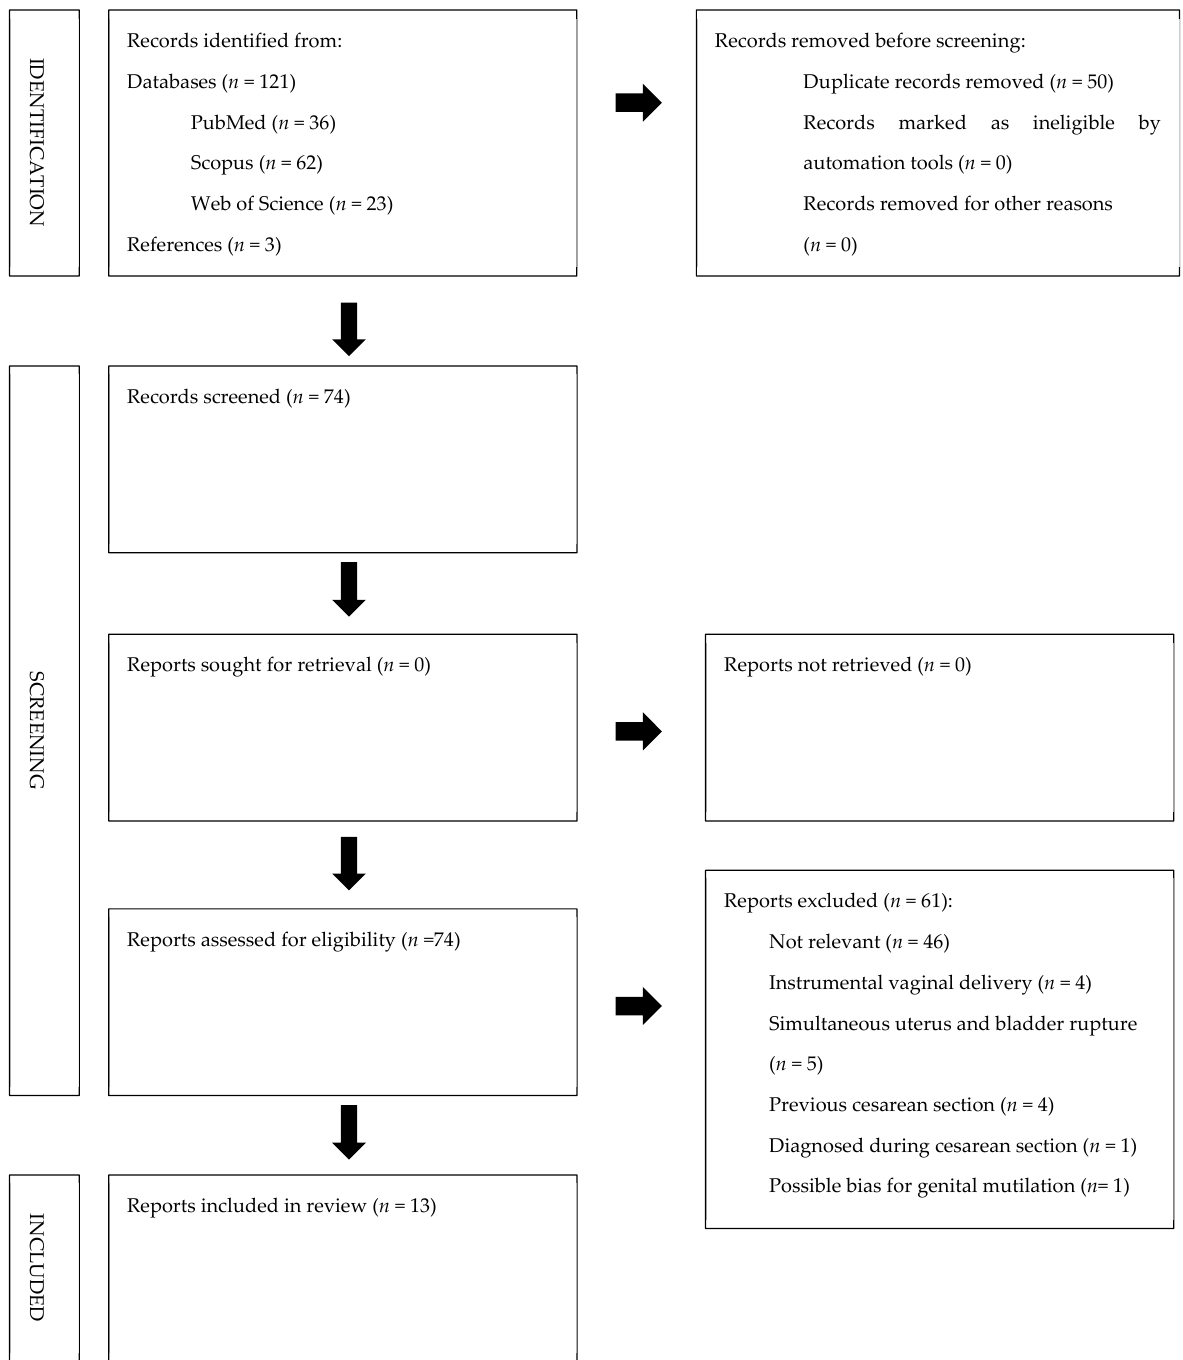
Figure 5. PRISMA flow diagram.